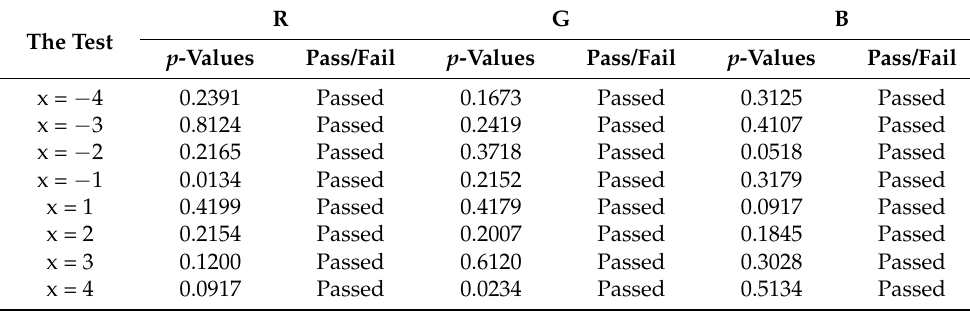
Table 15. Random excursions